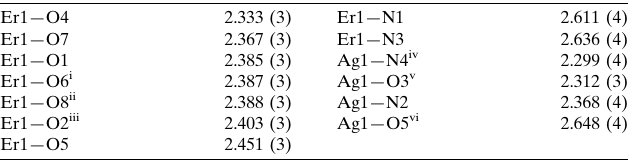
Selected bond lengths (A˚